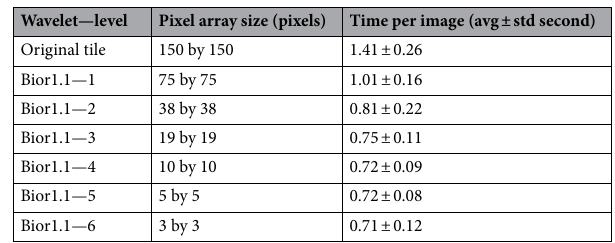
Table 2. Execution times of the proposed feature extraction methodology for the original image and different levels of